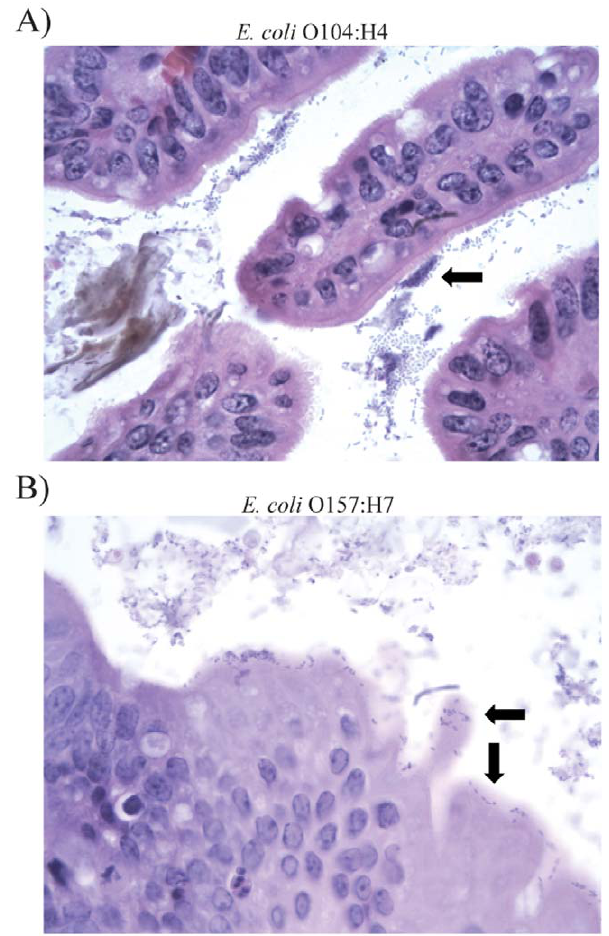
Figure 1. Histological examination of cecal tissue. Arrows highlight A) bacterial aggregation associated with the mucus layer in the cecum of E. coli O104:H4-infected mouse 11–272, and B) bacteria associated with the cecal mucosa in E. coli O157:H7-infected mouse 11– 437. Cells were stained with hematoxylin and eosin and magnified